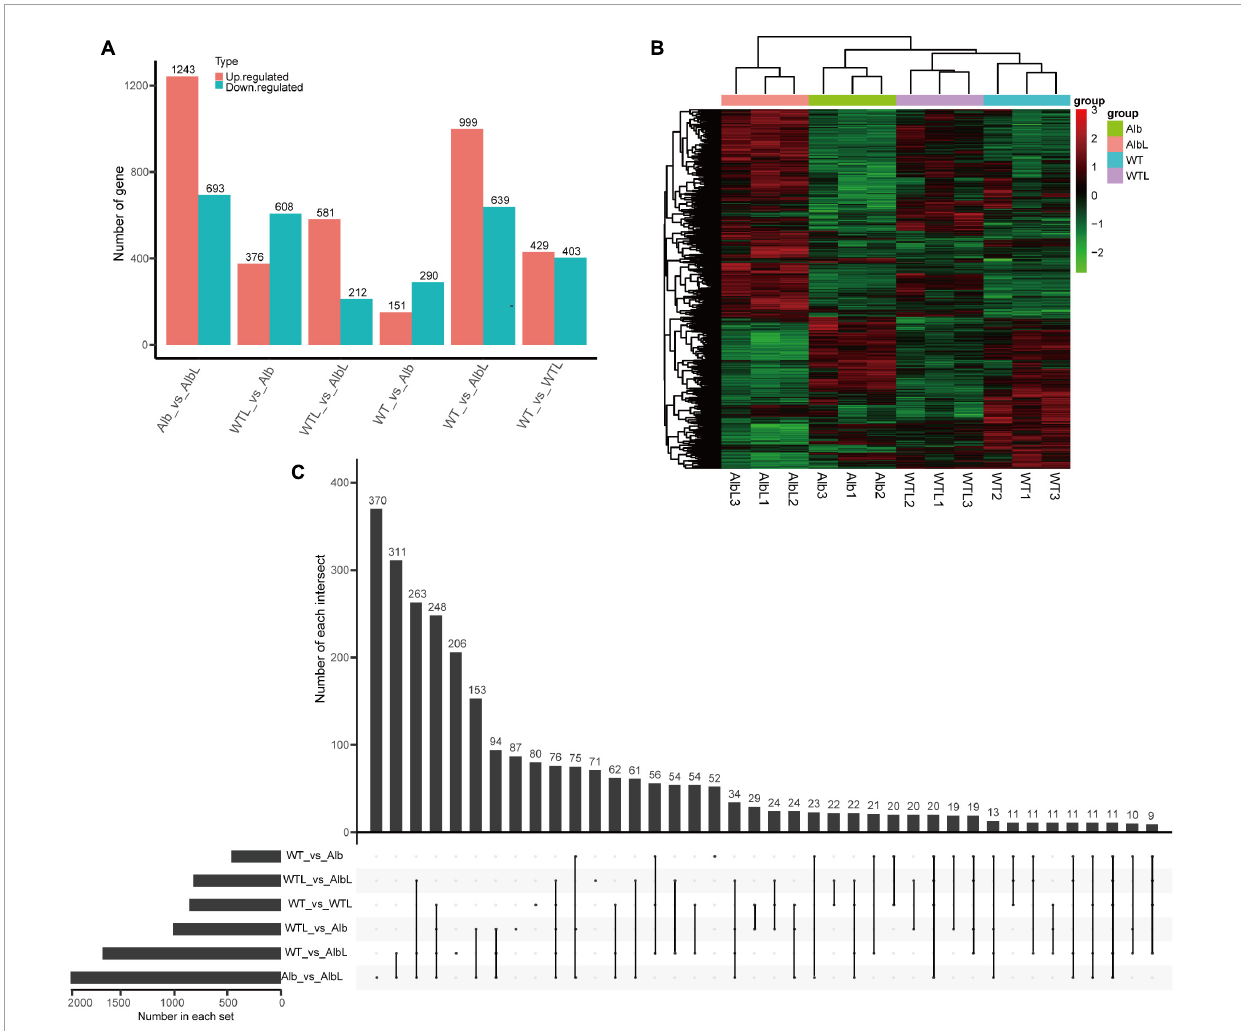
FIGURE4 Analysis of differential expression genes in WT and Alb before and after light treatment. (A) Statistics of the number of differentially expressed genes among different groups; (B) cluster analysis of differentially expressed genes in all samples; (C) analysis of differentially expressed gene number among multiple group. Number of each intersection, indicates the number of common differential genes identified by multiple comparison groups. Number in each set, indicates number of all differential genes identified in each group. WT, the mycelia of wild-type C. militaris before light treatment; WTL, the mycelia of wild-type C. militaris after light treatment; Alb , the mycelia of the albino mutant before light treatment; AlbL, the mycelia of the albino mutant after light